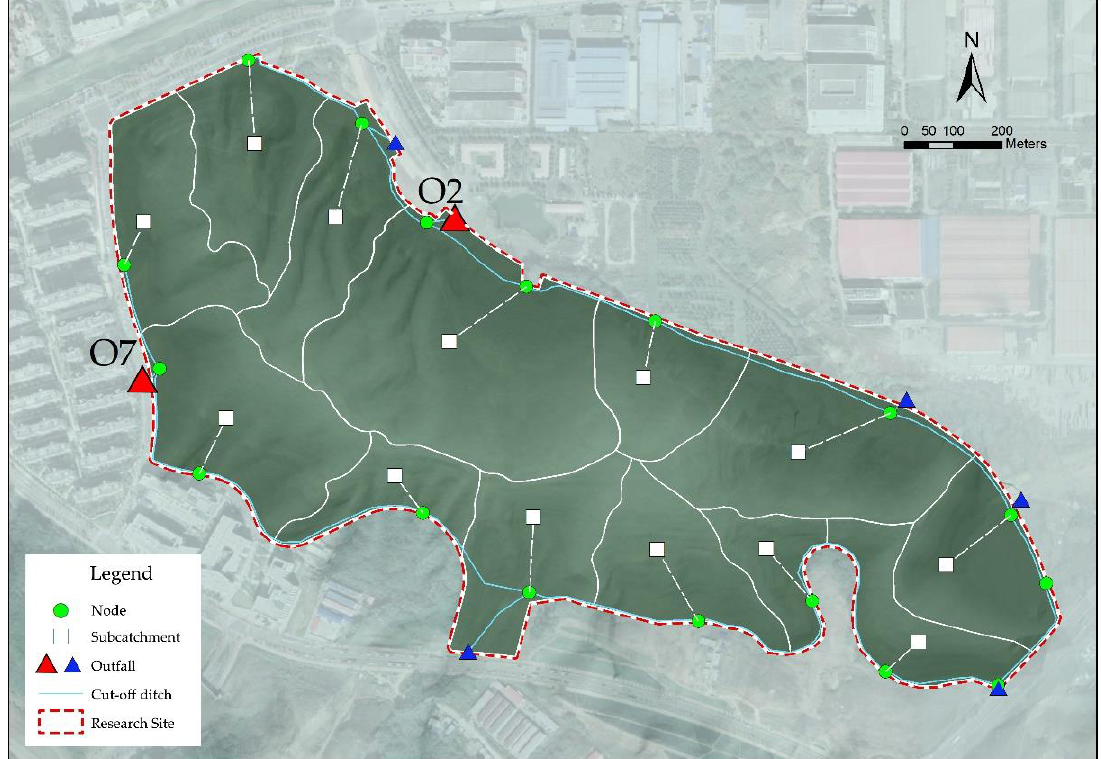
Figure 10. Schematic diagram of the representative outfalls O2 and O7.